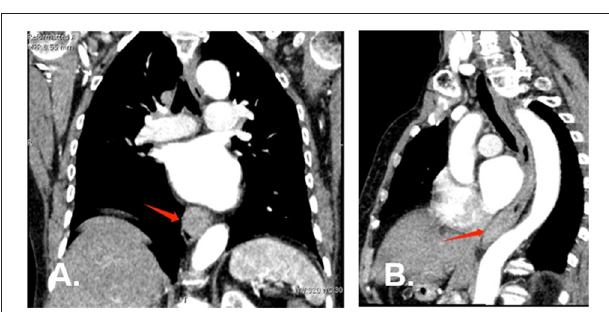
FIGURE 2 | Chest contrast-enhanced computed tomography at diagnosis. (A) (Coronal plane) and (B) (Sagittal plane) CT scan revealed a well-defined homogeneous soft tissue mass at the lower esophagus (red arrow).